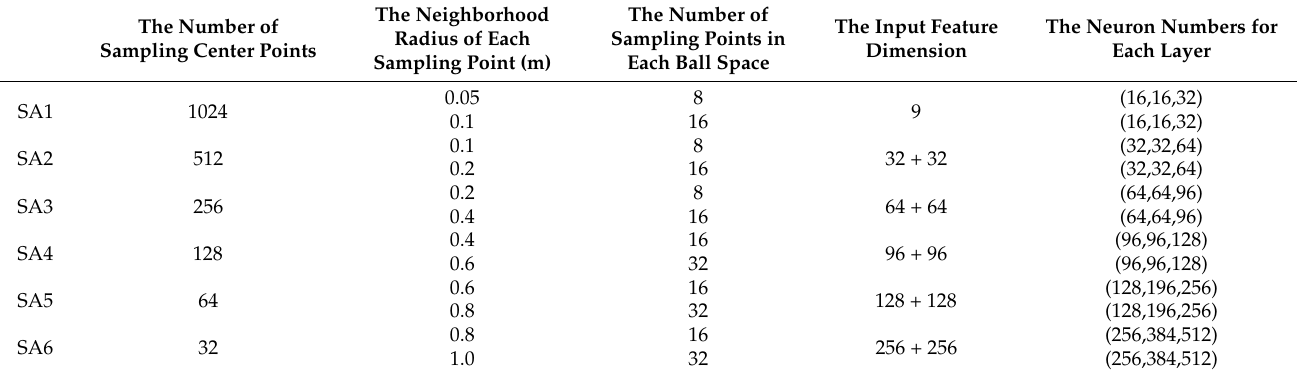
Table 1. The parameter information of the set abstraction layer where the SA1 to SA6 represent the first to sixth layers of the set abstraction layer, respectively.